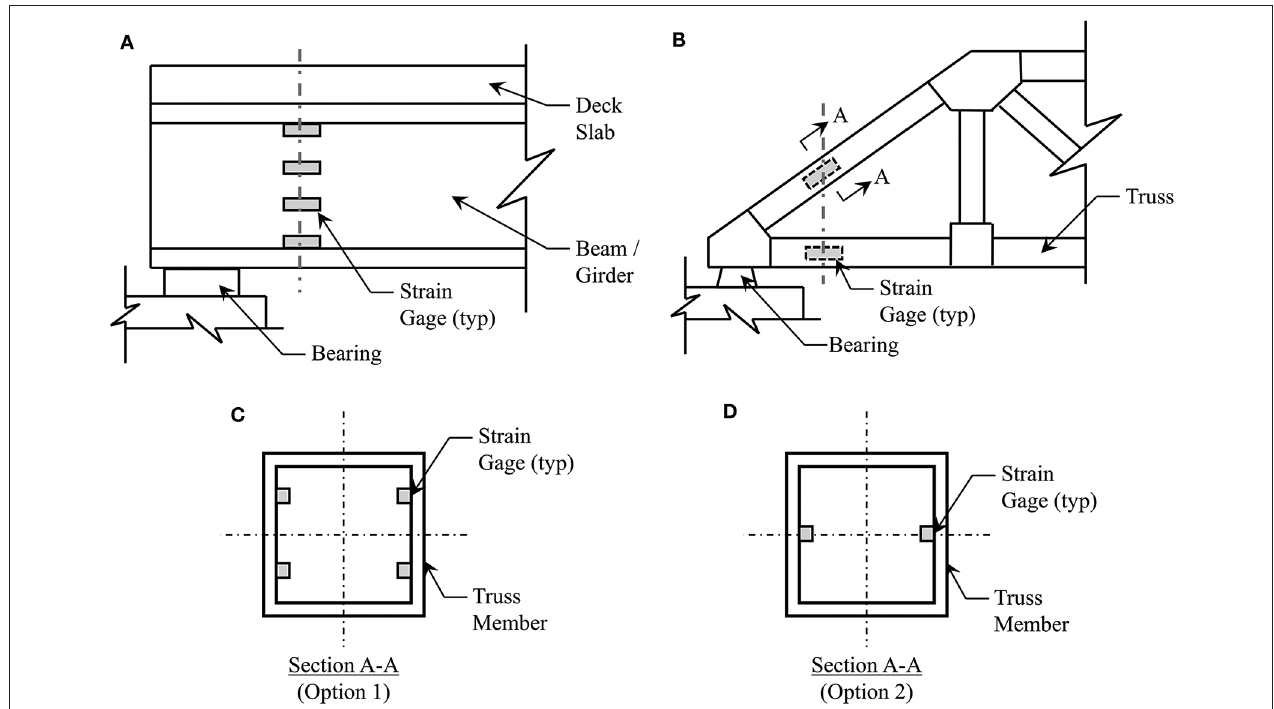
FIGURE 3 | Free-body slice general illustrations for (A) Girder bridges or (B) Truss bridges and the potential sensor cross-section layouts for a truss member using a (C) detailed option and (D) less refined